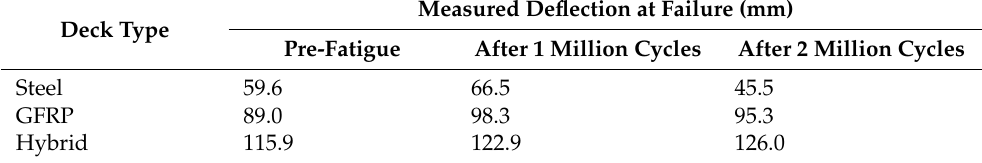
Table 9. Bridge deck deflection at